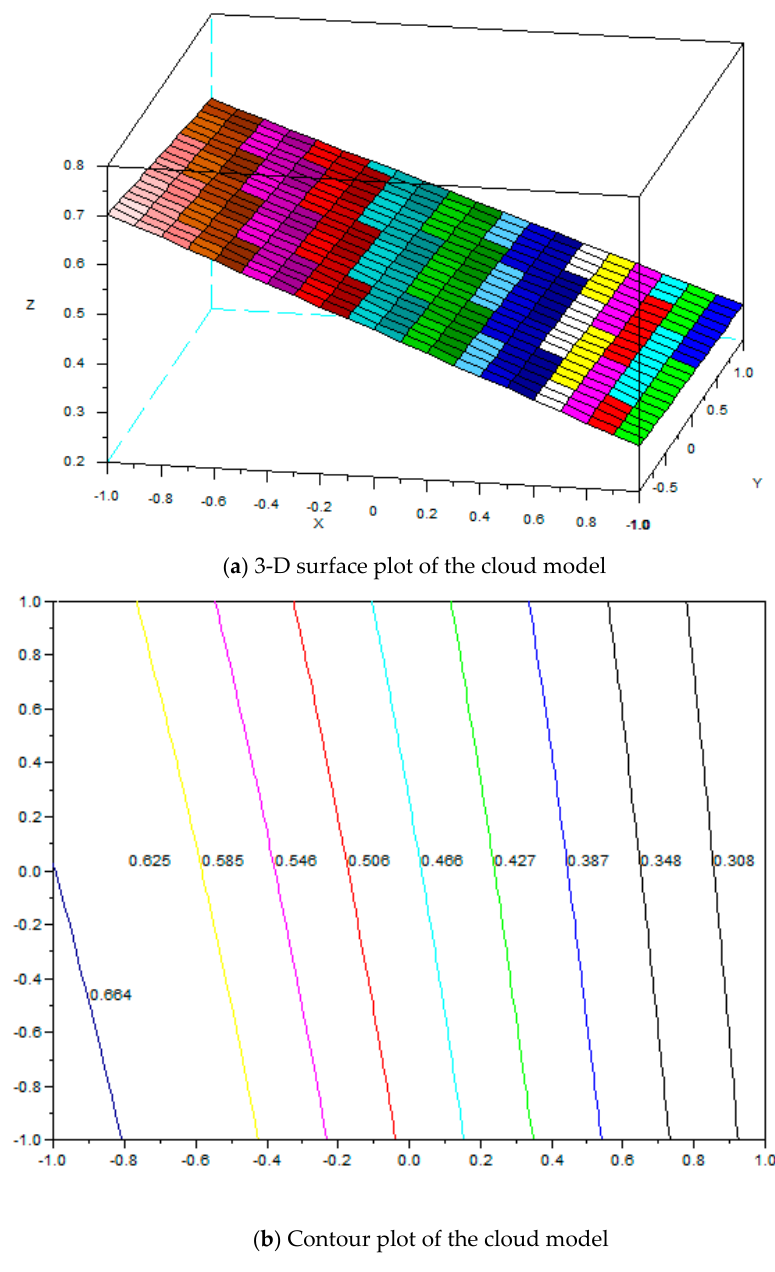
Figure 7. The mean response surface of cloud model.